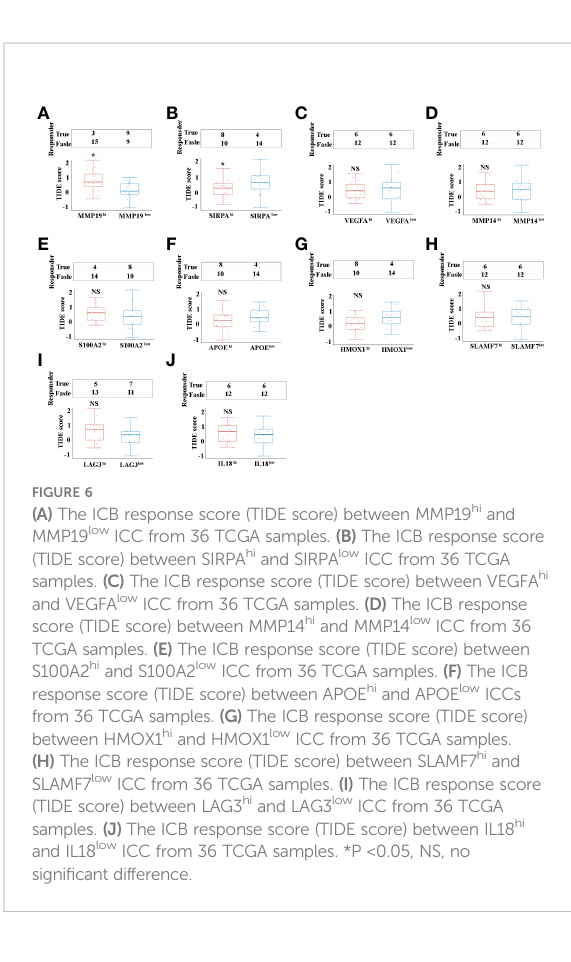
Figure 7A indicated the expression of MMP19 on macrophage